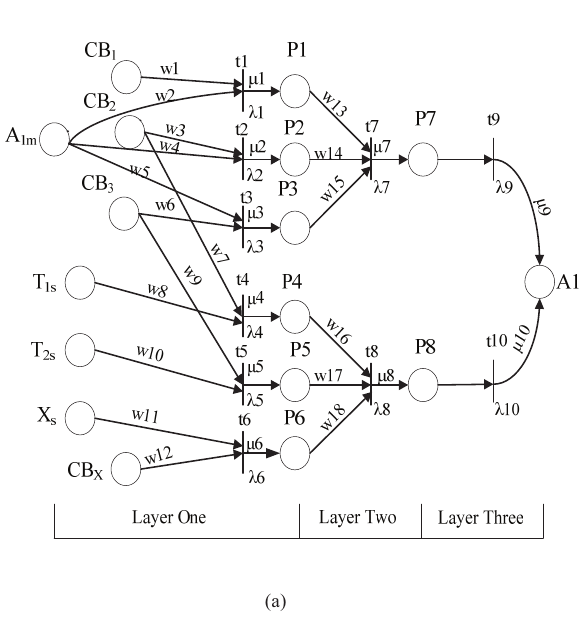
Fig. 3 A sample of power